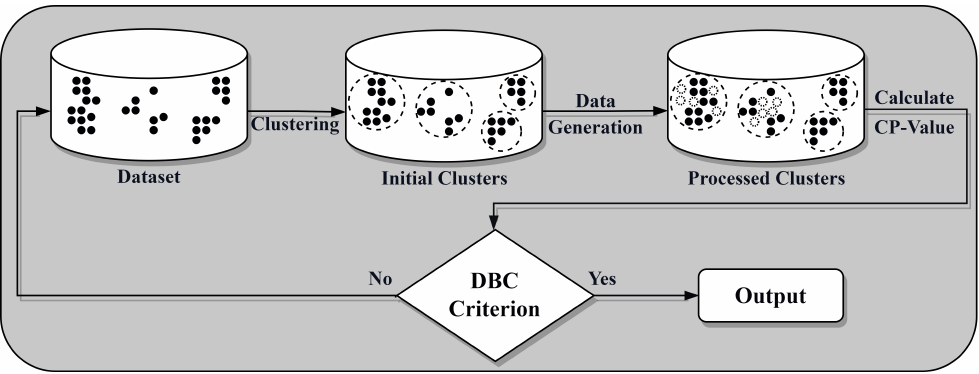
Figure 1. The procedure of DBC.